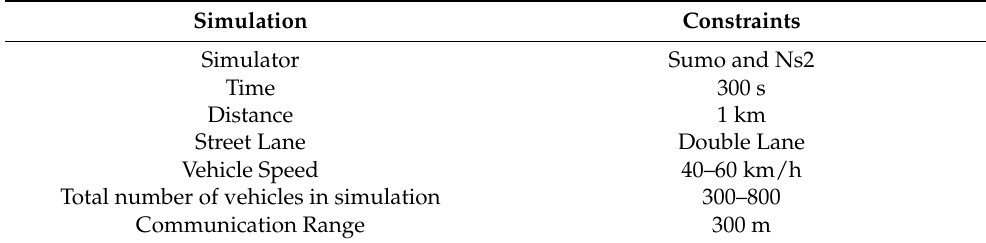
Table 2. Simulation